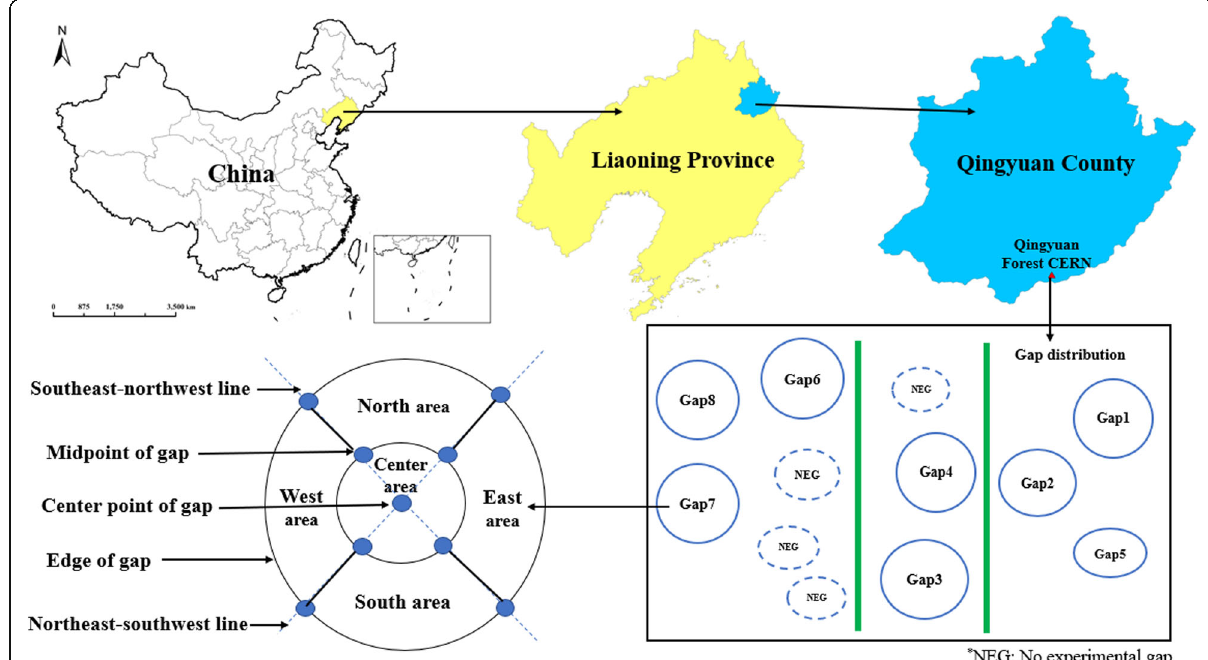
Fig. 2 Sketch map of sampling design in the experimental temperate secondary forest gaps in Qingyuan Forest CERN (a mountainous region of eastern Liaoning Province, Northeast